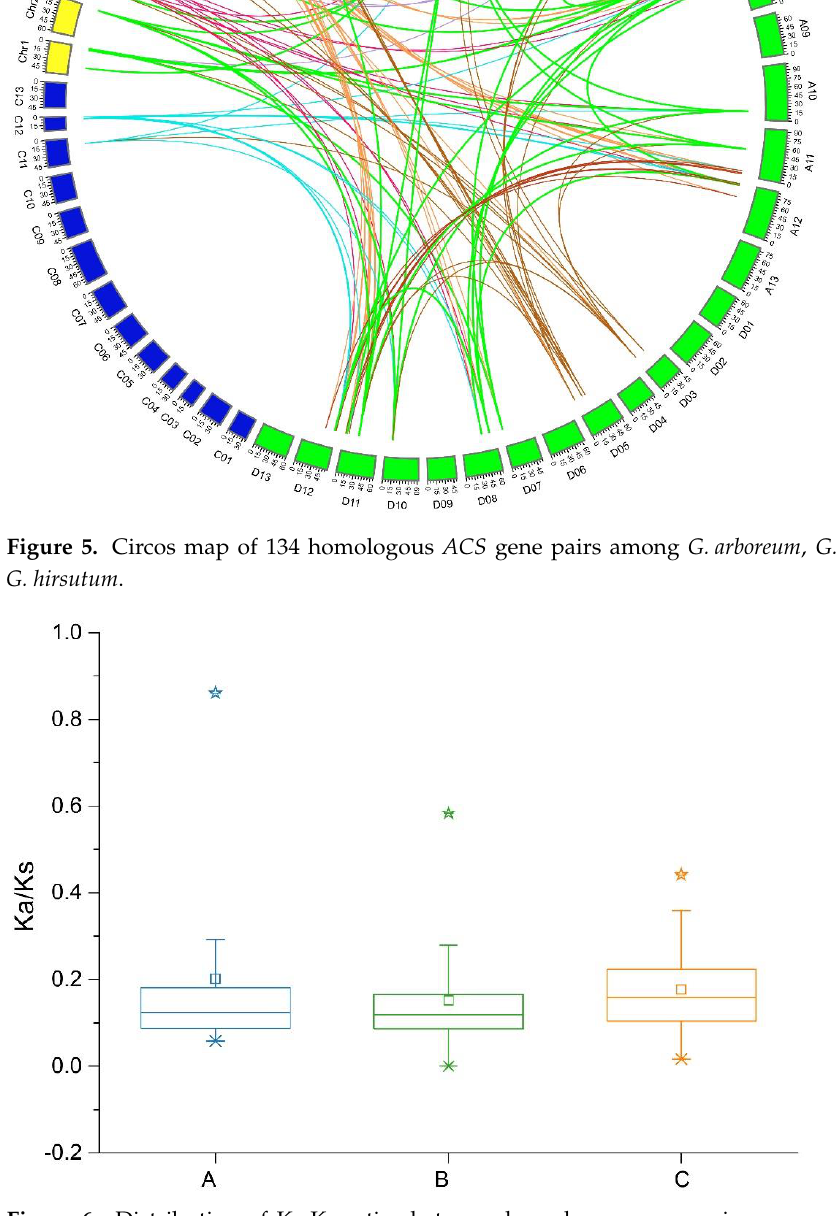
Figure 6. Distribution of Ka:Ks ratios between homologous gene pairs among G. arboreum , G. raimondii , and G. hirsutum . The Ka:Ks ratios of ACS gene pairs between G. arboreum and G. hirsutum (abscissa A), between G. raimondii and G. hirsutum (abscissa B), and in the G. hirsutum genome (abscissa C) are shown. The pentagrams, suqares, asterisk and long lines in boxes represented the outliers, means, minimum vaules and median line in each group of the Ka:Ks ratios, respectively; Boxes represented the 25%~75% range of the Ka:Ks ratios; The two short lines up and down represent range within 1.5 interquatile range.